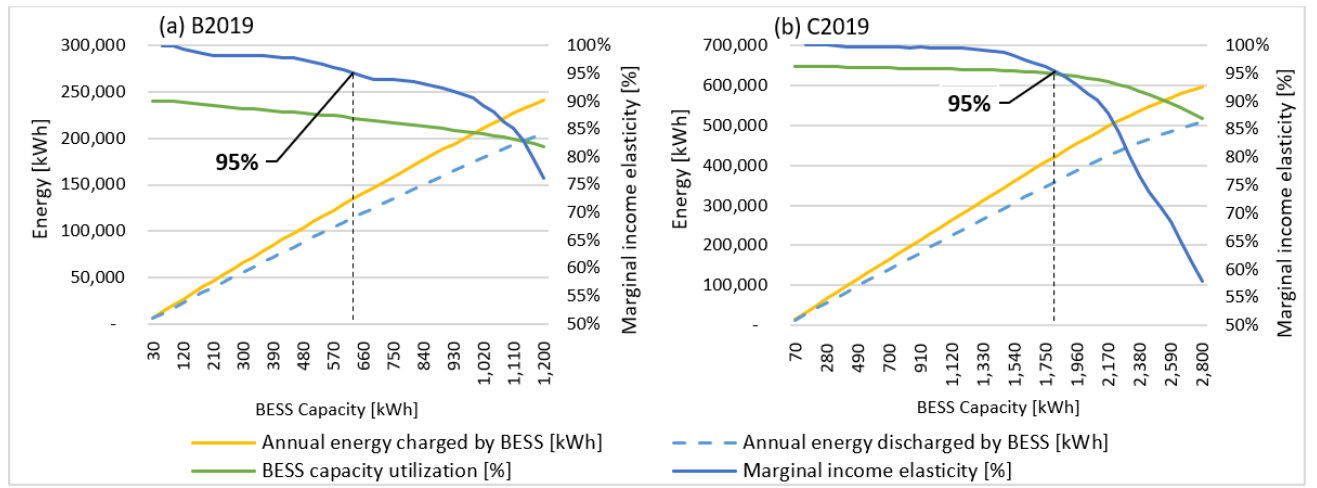
Figure 5. Results of simulations of the price arbitrage strategy: ( a ) B2019; ( b ) C2019. The arbitrarily adopted value of 95% for the marginal income elasticity parameter clearly indicated the existence of an effective value of the energy storage capacity. The effective value of energy storage capacity was visible in the B2019 and C2019 graphs near or before the characteristic point that resulted from the limitations of the microgrid. Table 6 shows the BESS parameters in points for which the marginal income elasticity parameter is equal to 95%. Table 6. Numerical results of the price arbitrage simulation for enterprises B2019 and